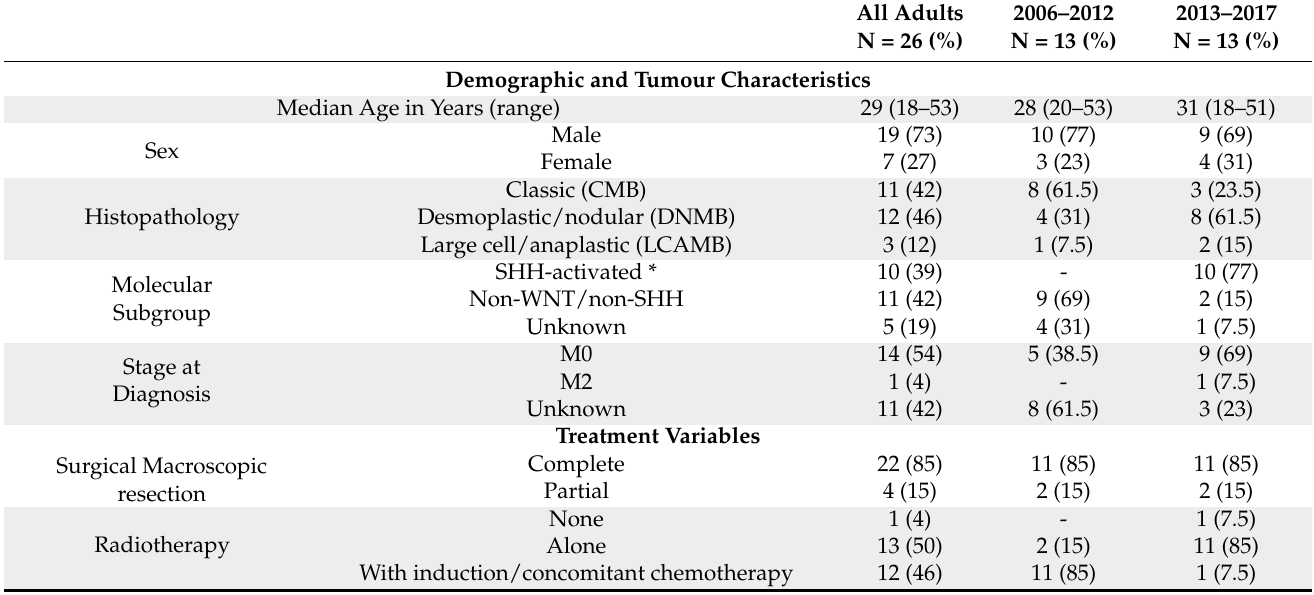
Table 2. Adult Baseline Characteristics and Treatment Regimen Based on Year of Diagnosis